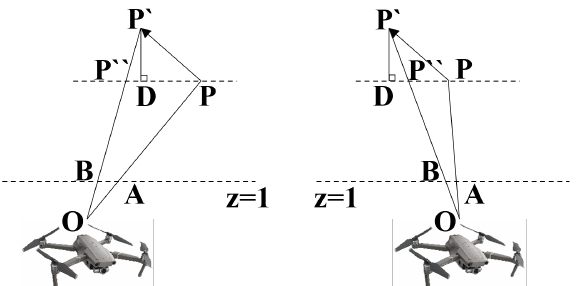
Figure 2. Illustration of depth calculation for any pair of corresponding